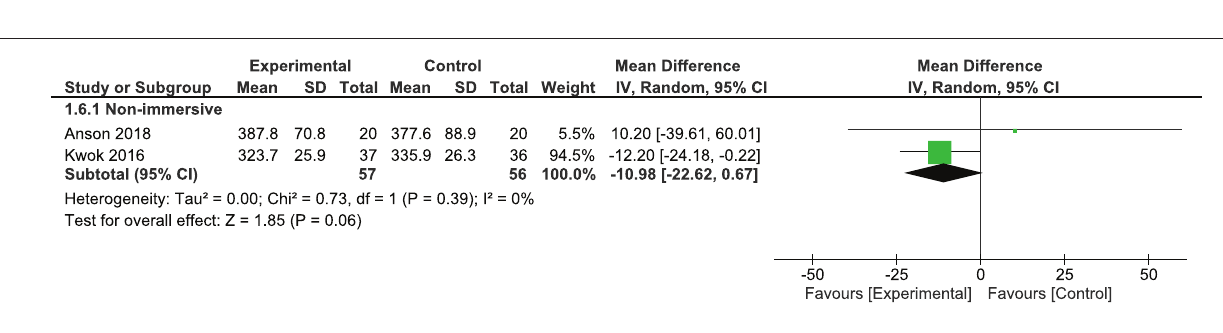
FIGURE 4 | Forest plot of timed tasks, specifically 6MWT, for functional mobility outcome measures for VR-based therapy vs. control